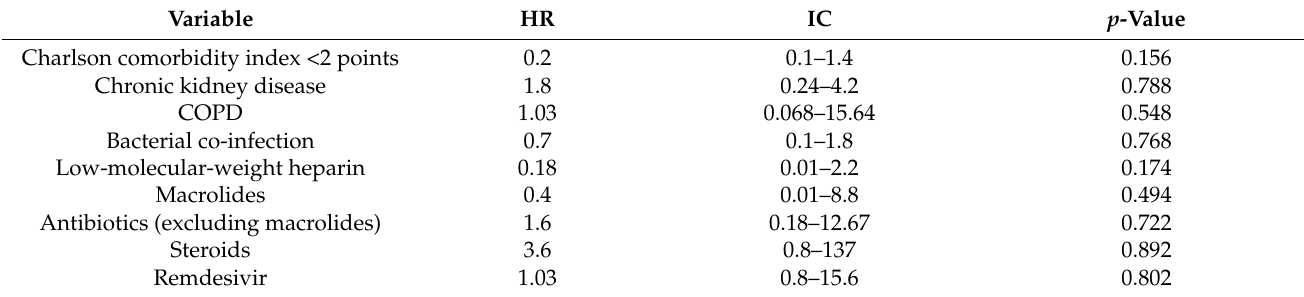
Table 5. Multivariate Cox regression analysis of need for non-invasive or invasive ventilation after propensity score